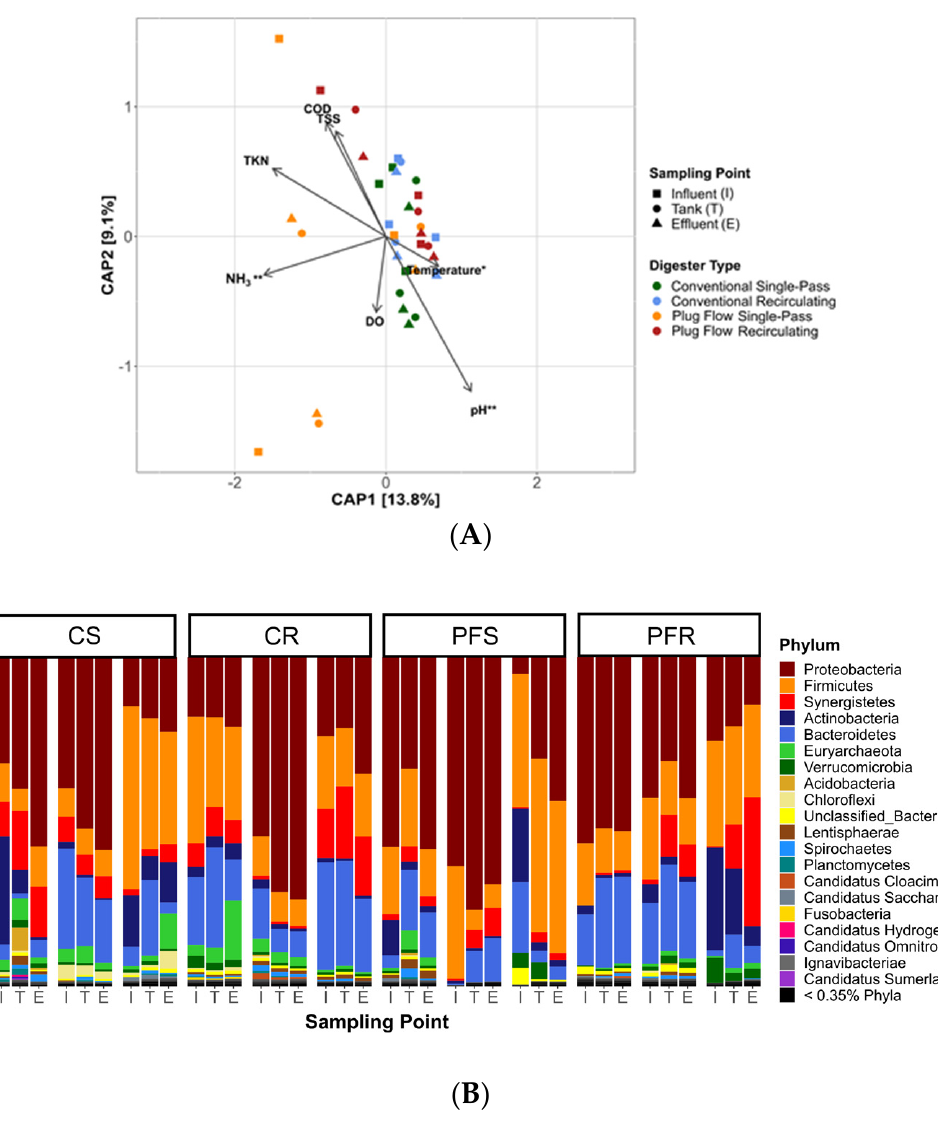
Figure 1. ( A ) Redundancy analysis of digester type and sampling point constrained against chemical parameters. Chemical parameters that significantly influenced the ordination revealed by the PERMANOVA test are denoted with asterisks (adj. p < 0.05), where “**” 0.01, “*” 0.05. ( B ) Relative abundance bar graphs showing the top 20 phyla for triplicate plug flow-type single-pass (PFS), plug flow-type recirculating (PFR), conventional single-pass (CS), and conventional recirculating (CR) across sampling points. The lowest abundant phyla were aggregated into a cutoff percentage labeled in black.